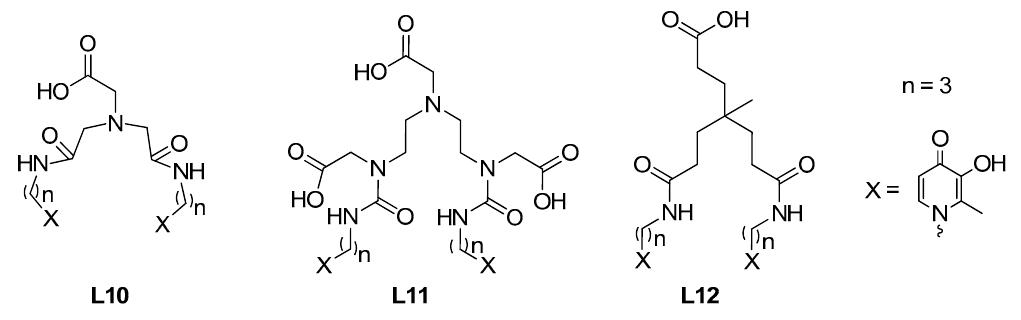
Figure 5. Bis-3-hydroxy-4-pyridinones employed for possible environmental applications. The reported thermodynamic studies on the mentioned bis-3-hydroxy-4-pyridinones (L) and the speciation models revealed the formation of stable mononuclear and binuclear protonated species (M p L q H r ; p, q = 1-2, r = 1-4) with 1:1 and 1:2 stoichiometry (ML, ML 2 ),